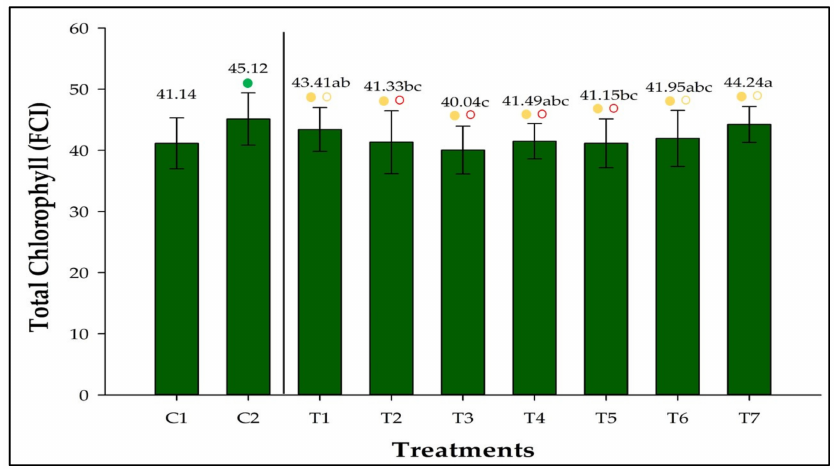
Table 3. Photosynthetic efficiency (PE), stomatal conductance (gs), internal CO 2 concentration (Ci), leaf transpiration (T), water use efficiency (WUE), and carboxylation efficiency (CUE) in strawberries inoculated with Azospirillum brasilense , Bacillus megaterium , and Brevibacillus fluminis , alone and in mixtures. Means are followed by their standard deviations.